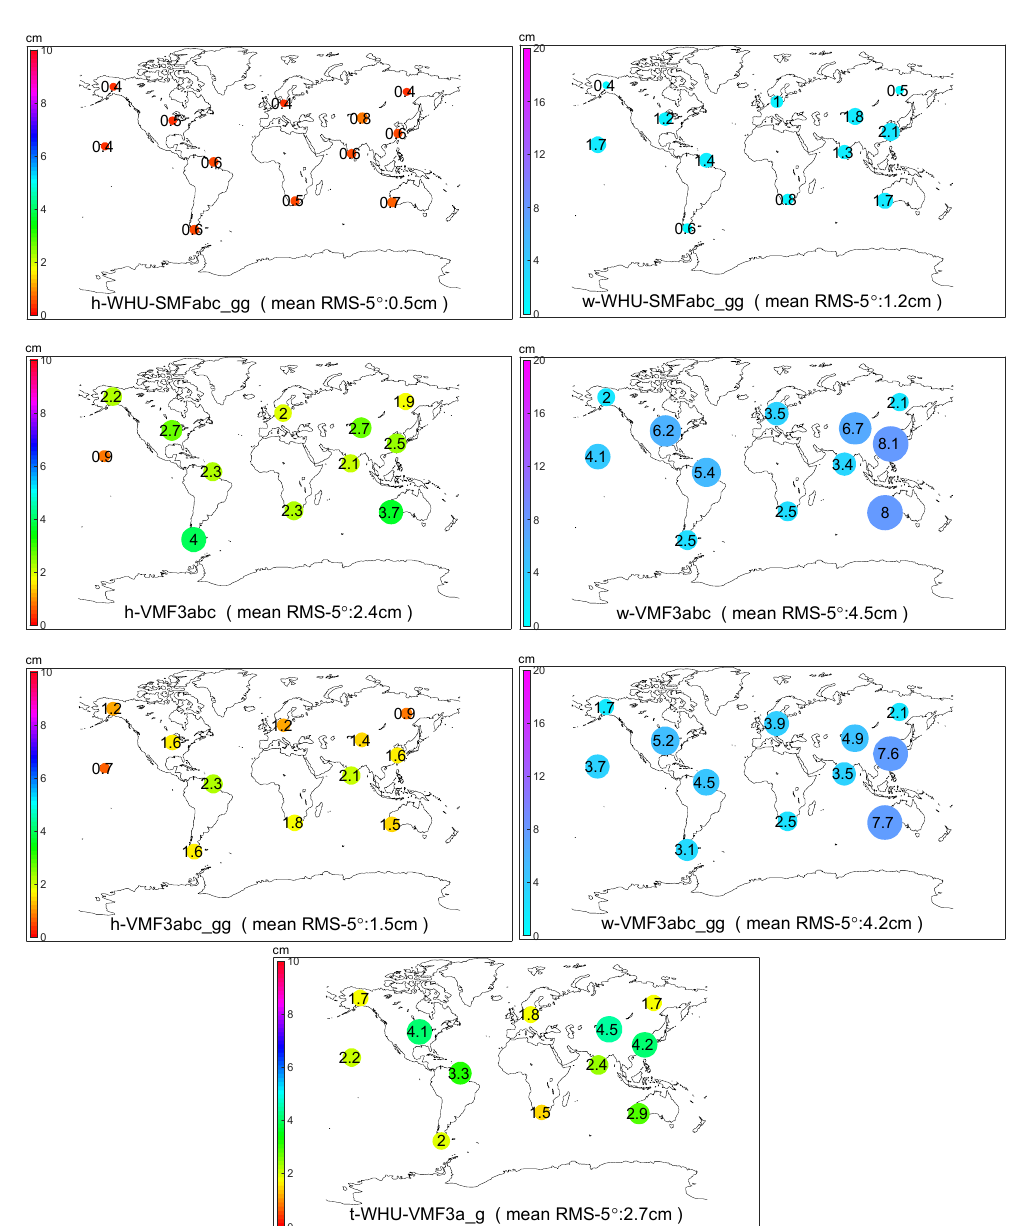
Figure 9. The RMS of various mapping functions at the 5° elevation angle without or with gradients estimation for the 12 IGS stations on doy 74, 202, 246, and 360 in 2018. The size and the color of a circle denote the RMS 5° value of the station, of which digit is also marked inside the circle.